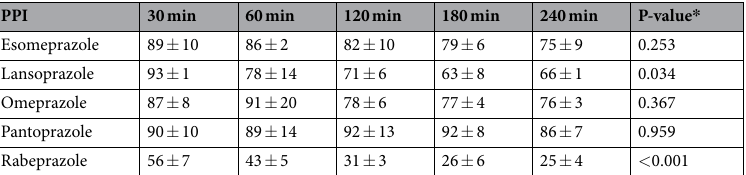
The following variables were associated (P < 0.2) with ADMA concentrations and were entered into regression analysis: age, gender, history of myocardial infarction and stroke, diabetes, regular alcohol consumption, use of statins, beta-blockers, diuretics, renin-angiotensin system inhibitors and antiplatelet drugs, total, HDL and LDL-cholesterol, triglycerides, C-reactive protein, and eGFR. In adjusted multivariable regression analysis, PPI use was not independently associated with ADMA concentrations (beta 0.079, 95% CI − 0.001 to 0.025, P = 0.077; Supplementary Table S2). Furthermore, there were no significant differences in ADMA concentrations between users of the five PPIs studied (P = 0.748 for trend, Table 4).